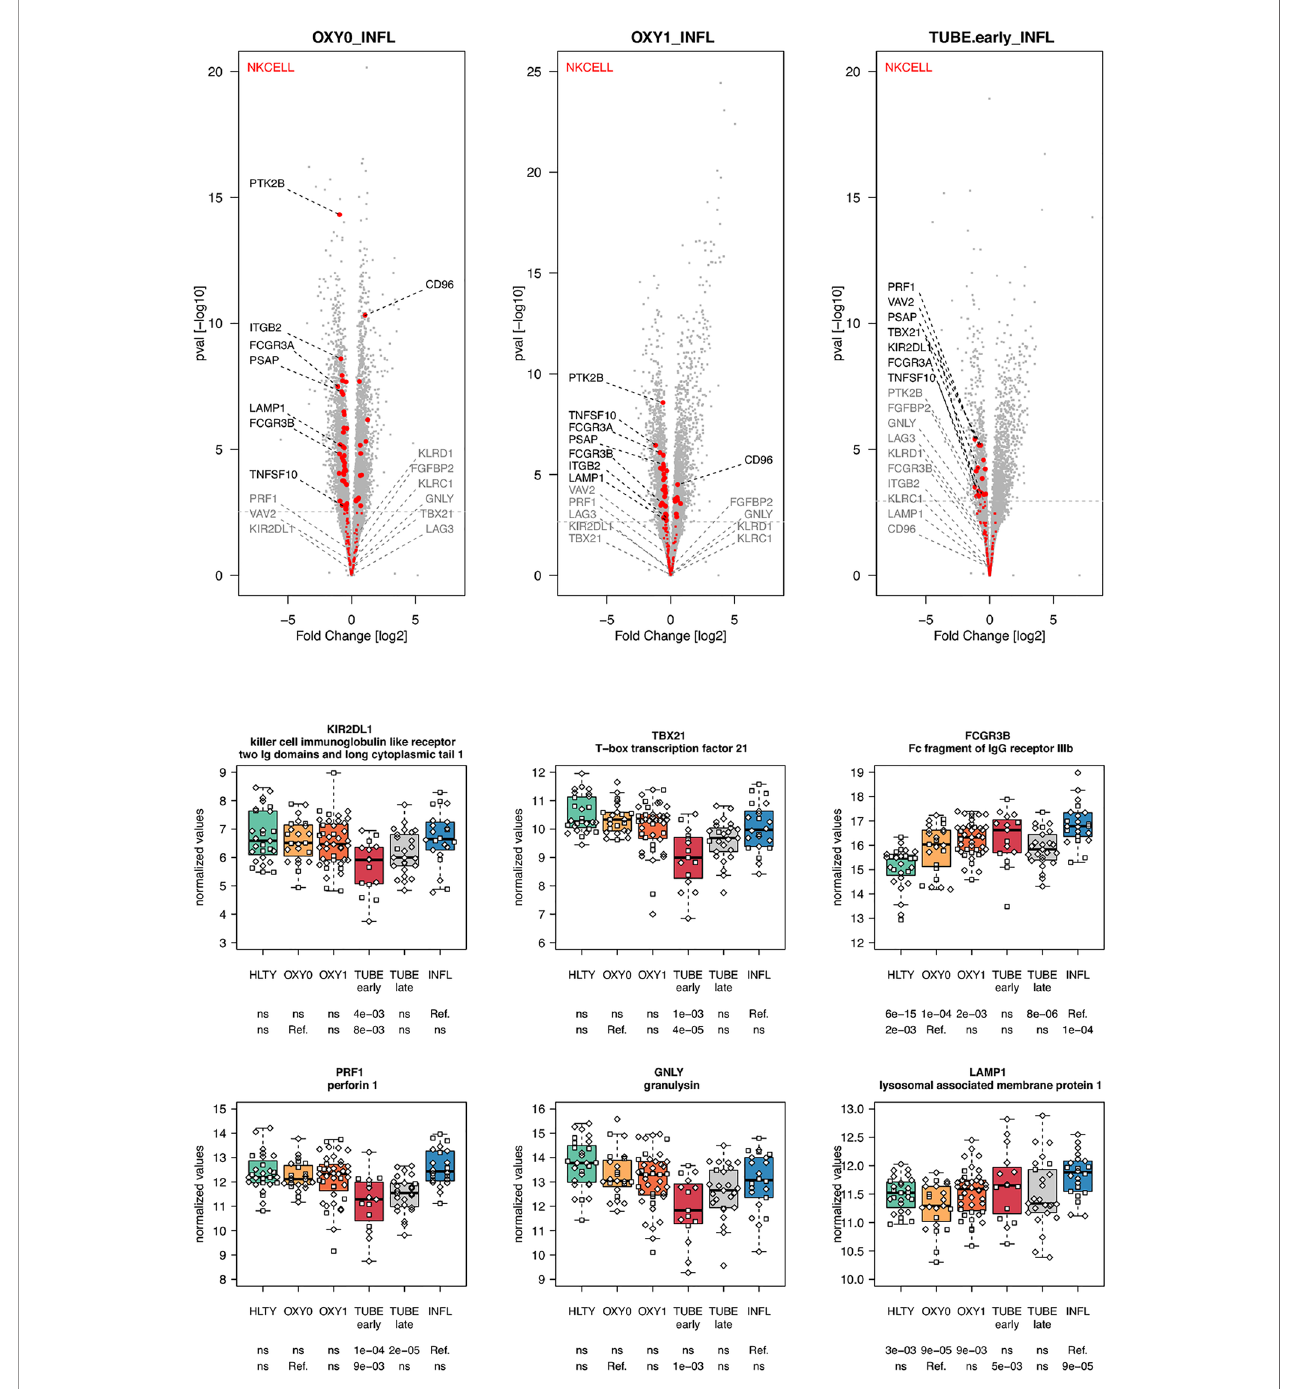
FIGURE 5 | Differentially expressed genes (DEGs) involved in NK cells function and regulation. Upper panel: for each comparison indicated in the volcano plot header, the distribution of log2 fold changes and P-values of all detected genes is shown as gray dots. Red dots indicate genes involved in NK cells function and regulation. Genes ’ sets are selected from different GO, REACTOME and/or KEGG pathways (see Supplementary Table 2 ). The dotted horizontal gray line indicates the limit under which – log10(P-value) becomes non signi fi cant once adjusted for multiple testing (adjusted P > 0.01). Lower panel shows detailed expression levels of selected genes involved in NK cells function and regulation in the different groups of patients. Groups used for comparisons include SARS-Cov-2 infected patients (no oxygen support [OXY0], oxygen support [OXY1], intubation with sampling within 7 days [TUBE early] or >7 days [TUBE late] after hospital admission), In fl uenza virus [INFL] infected patients and non-infected controls [HLTY]. Adjusted P-values of pairwise comparisons between a reference group (Ref.) and another group are indicated below the x axis. Ref. is taken as [INFL] and [OXY0] on the fi rst and second line,